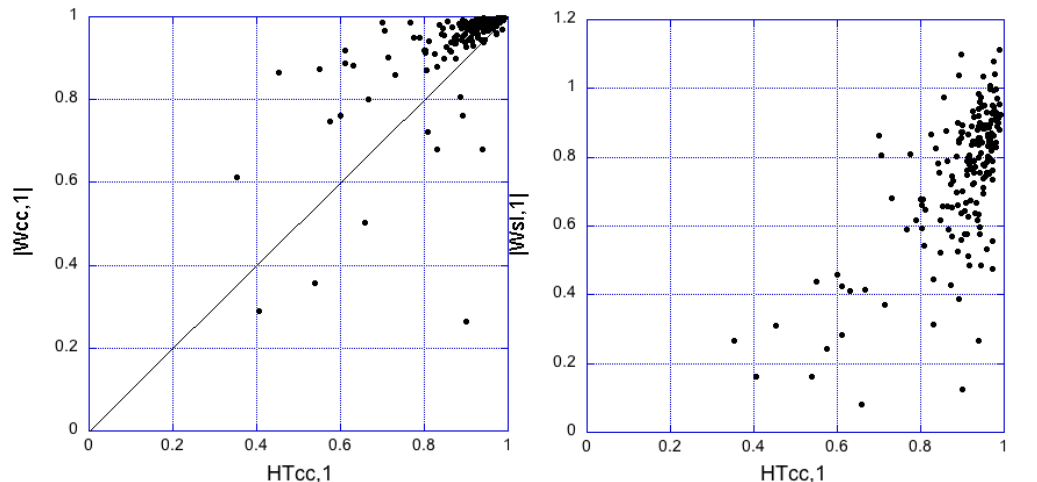
Fig. 4. Scatterplots of the Wal´en correlation coefficients W cc , 1 (left) and Wal´en slopes W slope , 1 (right) versus the HT correlation coefficients HT cc , 1 for the centered 1min intervals of all 188 cases. In the plot on the right a single point is